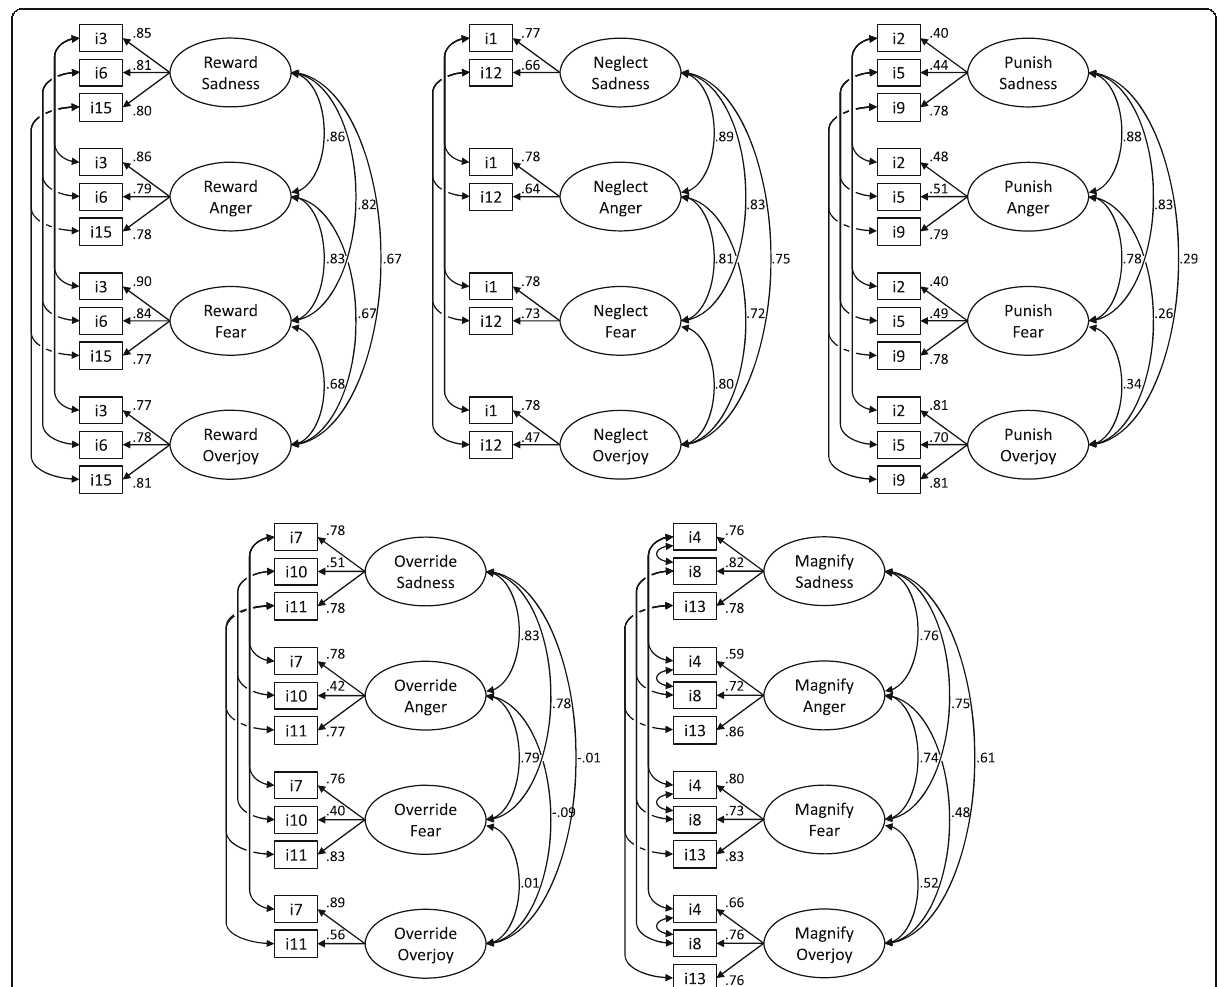
Fig. 1 Path diagrams for the final five models of emotion socialization strategies. i = item. For simplicity, item errors are